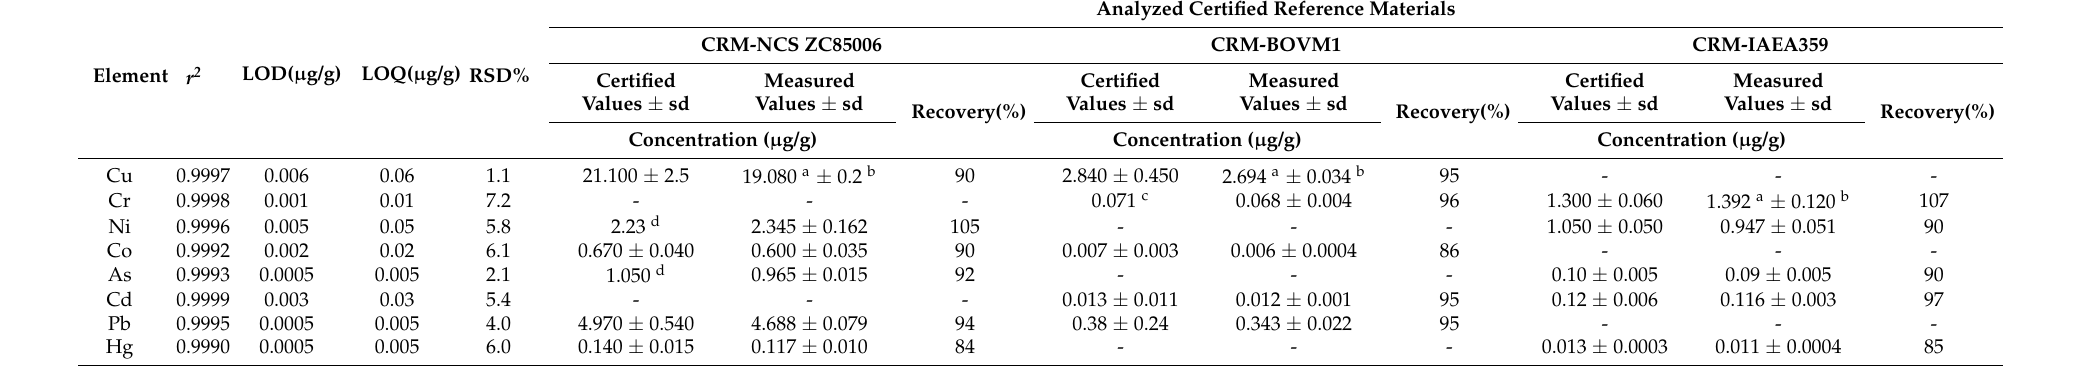
Table 1. Analysis of certified reference